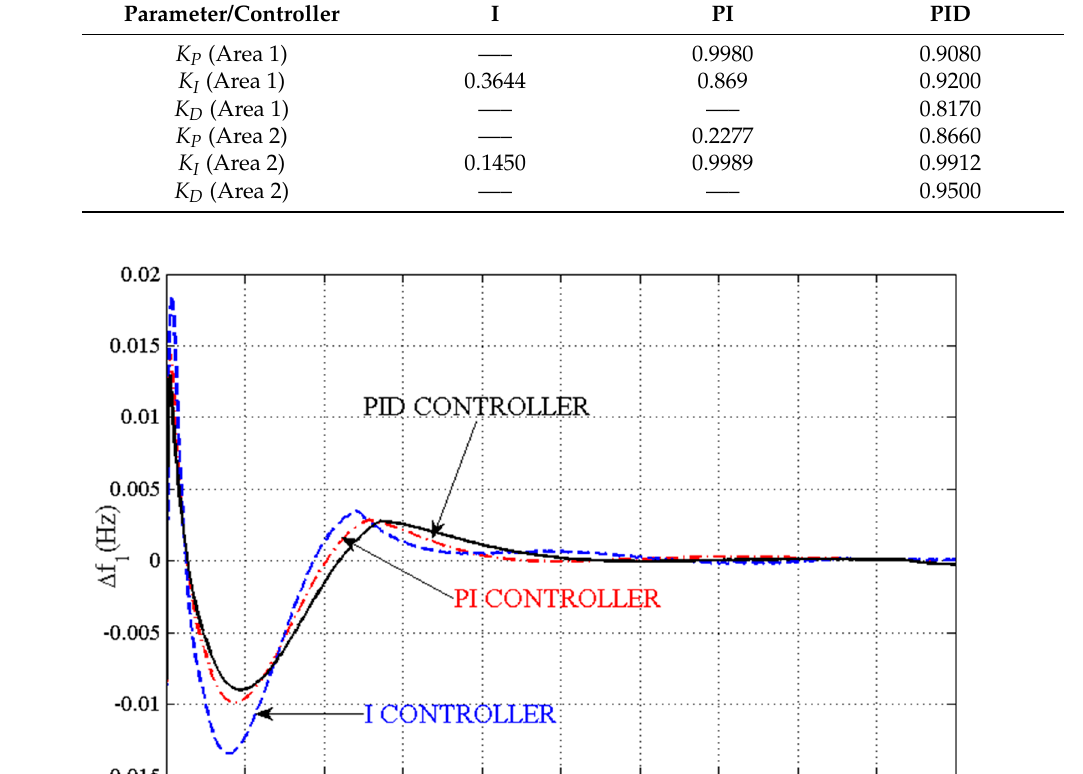
( c ) Figure 8. Comparison of SAO-tuned classical controllers’ dynamics. ( a ) ∆ f 1 ; ( b ) ∆ f 2 ; and ( c ) ∆ P tie . Table 2. The se tt ling durations and highest and lowest magnitudes of Figure 8 responses. Response/Dynamic Measures 0.16 It is clear from Figure 8 and Table 2 that between the three classical controllers, the PID controller is superior in terms of the SD, HM, and LM measures. The critical evalua- tions of the results for this case are explained herein. The ∆ f (Area 1) graph shows a 53.76% and 20.17% improvement in the SD with PID in comparison with the I and PI controllers. With the PID controller, a 6.25% and 1.03%